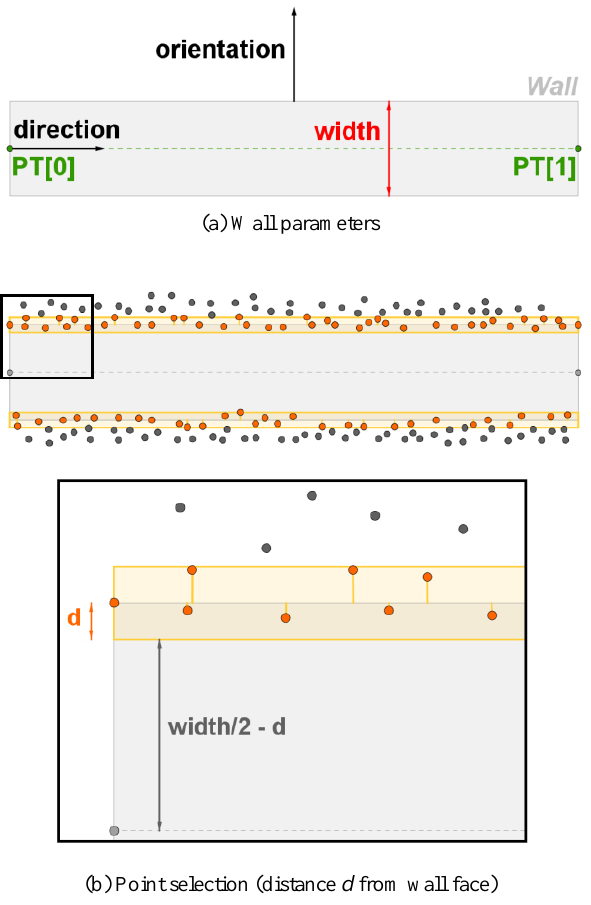
Figure 3: Point selection in both sides of the